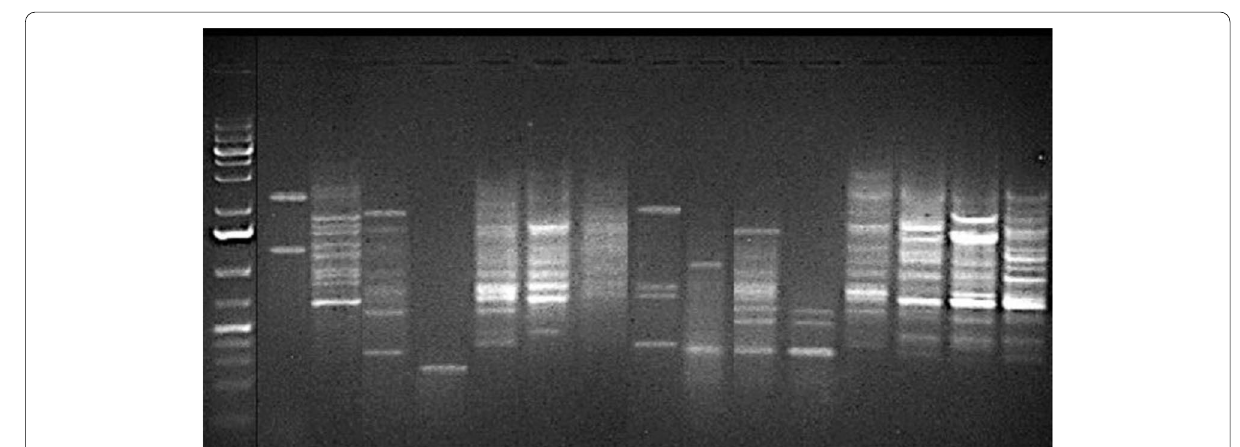
Fig. 3 A representative picture of (GTG)5 PCR fingerprints of DEC